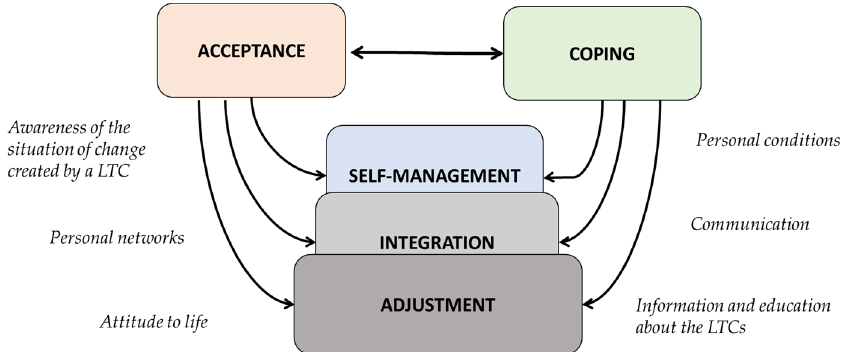
Figure 2. Interrelationships between the attributes of living with LTCs from the perspective of the family caregiver and mechanisms involved.